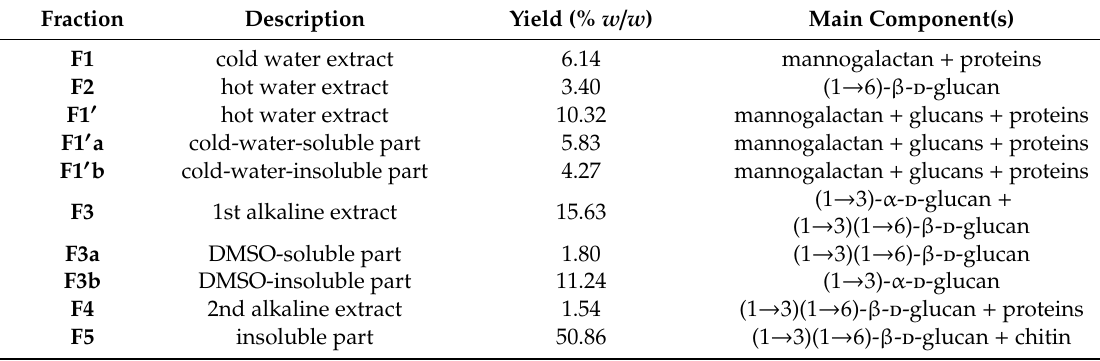
Table 1. Yields of polysaccharidic fractions obtained from basidiocarps of P. ostreatus